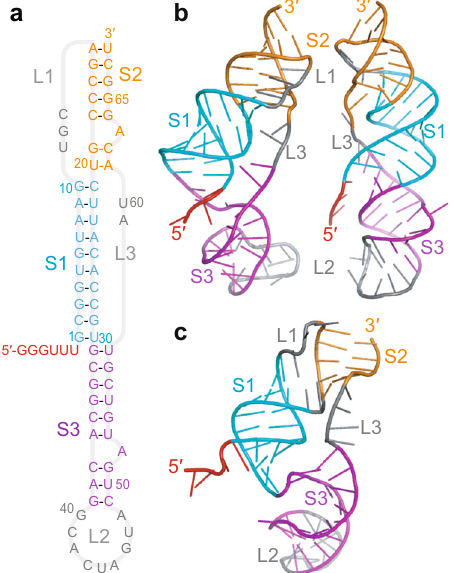
Fig. 1 Three-stemmed architecture of SARS-CoV-2 frameshift- stimulatory pseudoknot. a Secondary structure from Ref. 1 , with stems and loops color-coded (S1: stem 1, cyan; S2: stem 2, orange; S3: stem 3, purple; L1/2/3: loop 1/2/3, gray). Spacer region linking to slippery sequence shown in red. b 3D structures of 5 ′ -threaded (left) and -unthreaded (right) conformers from Ref. 18 . c Cryo-EM structure from Ref. 15 (PDB ID